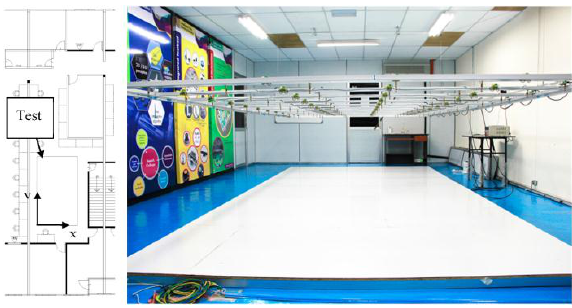
Figure 11. The layout of the laboratory and picture of the test area.